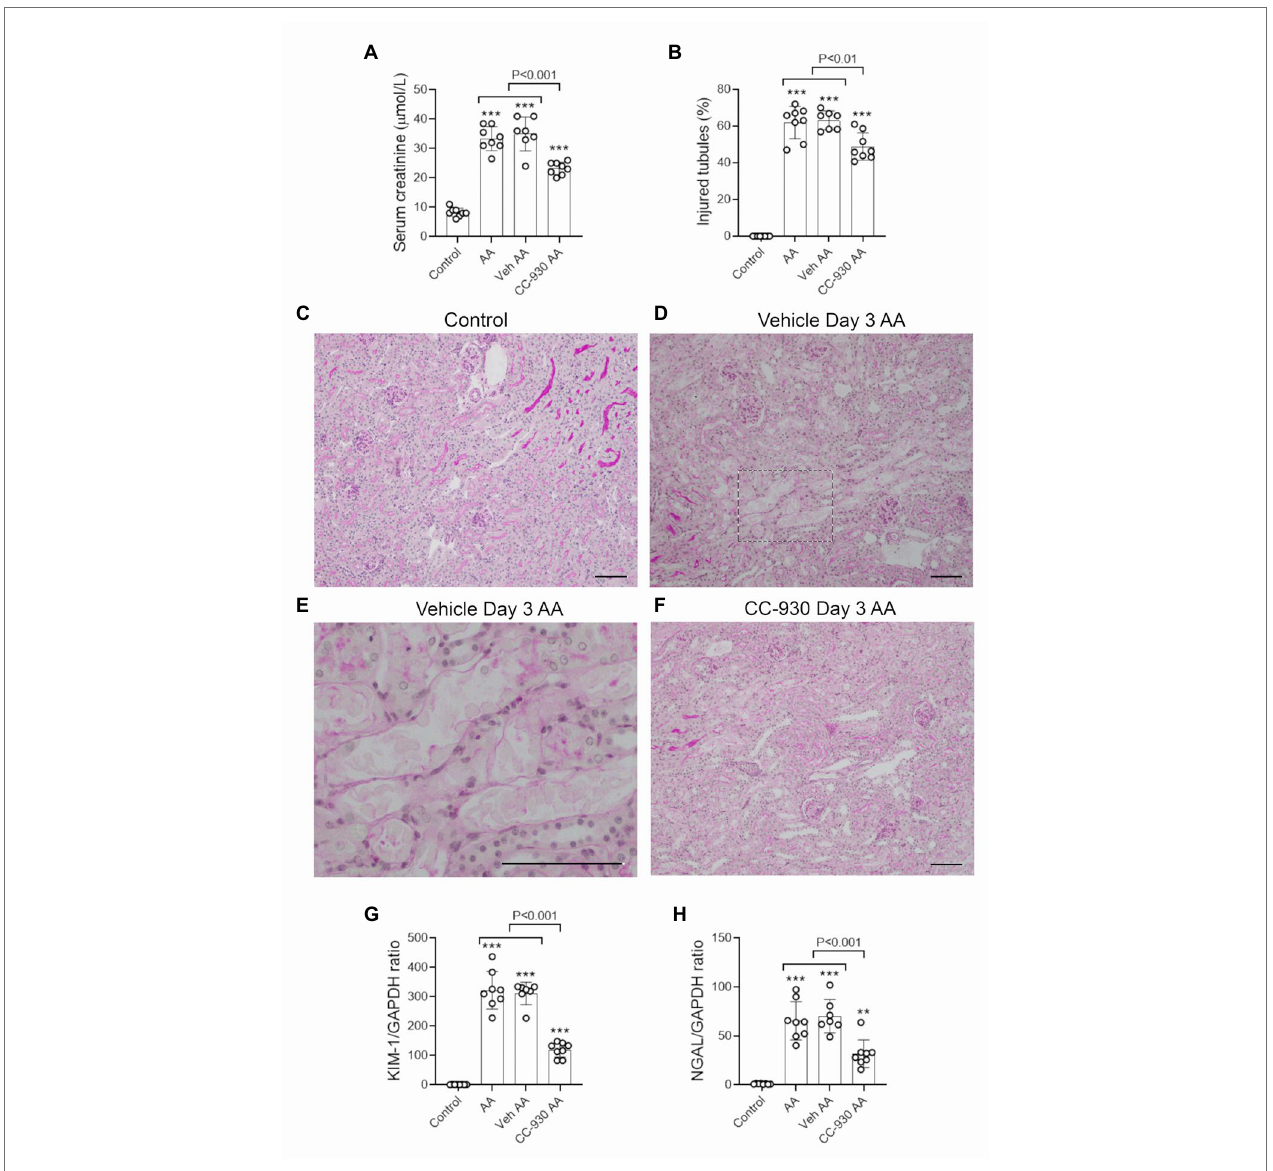
FIGURE 1 | Renal function and tubular damage on day 3 of aristolochic acid (AA)-induced acute kidney injury. AA-injected mice were either untreated (AA), or treated with vehicle (Veh AA) or CC-930 (CC-930 AA) and compared to normal controls. (A) Serum creatinine levels. (B) Graph of tubular damage score. (C – F) Periodic acid-Schiff (PAS) staining of kidney sections. (C) Kidney structure in normal control. (D) Vehicle treated AA showing damaged tubules with loss of brush border, loss of tubular nuclei and sloughing of cells into the lumen. (E) High power view of the image in D. (F) CC-930 treated AA shows less severe tubular damage compared to vehicle treated. Bars represent 100 μ m. Reverse transcription PCR (RT-PCR) analysis of mRNA levels for the tubular damage markers; (G) KIM-1/HAVCR1 and (H) NGAL/LCN2. One-way ANOVA with Tukey’s multiple comparison test. ** p < 0.01 and *** p < 0.001 vs.